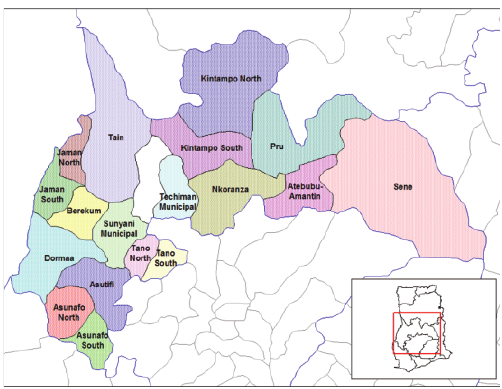
Figure 1: Map of Brong-Ahafo Region of Ghana (source: Google